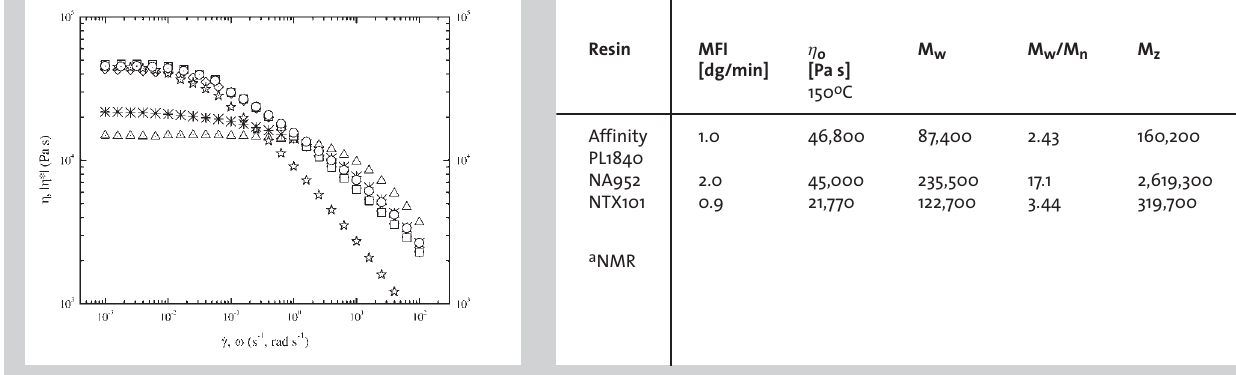
Figure 4: Viscosity versus shear rate for three polyethylene resins